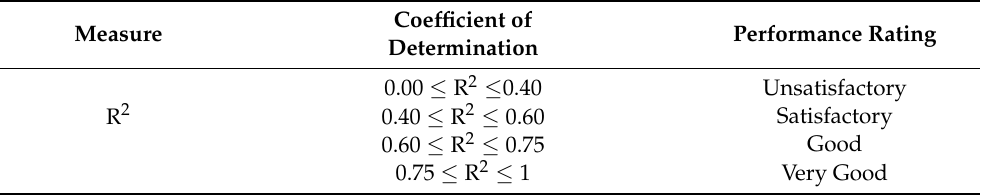
Table 8. General performance ratings of the recommended